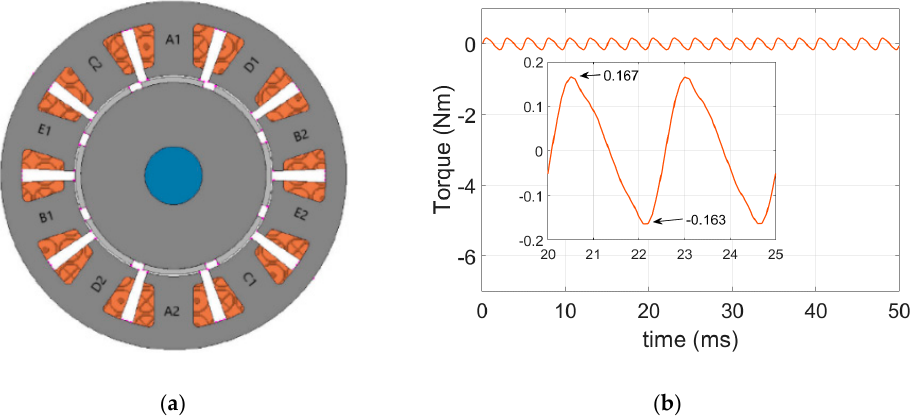
Figure 9. Simulated five-phase PM machine: ( a ) FEA model “Reprinted from Publisher, 2021 [44]”; ( b ) Cogging torque . Table 1. Parameters of The Five-Phase PM Machine “Reprinted from Publisher, 2021 [44]“.